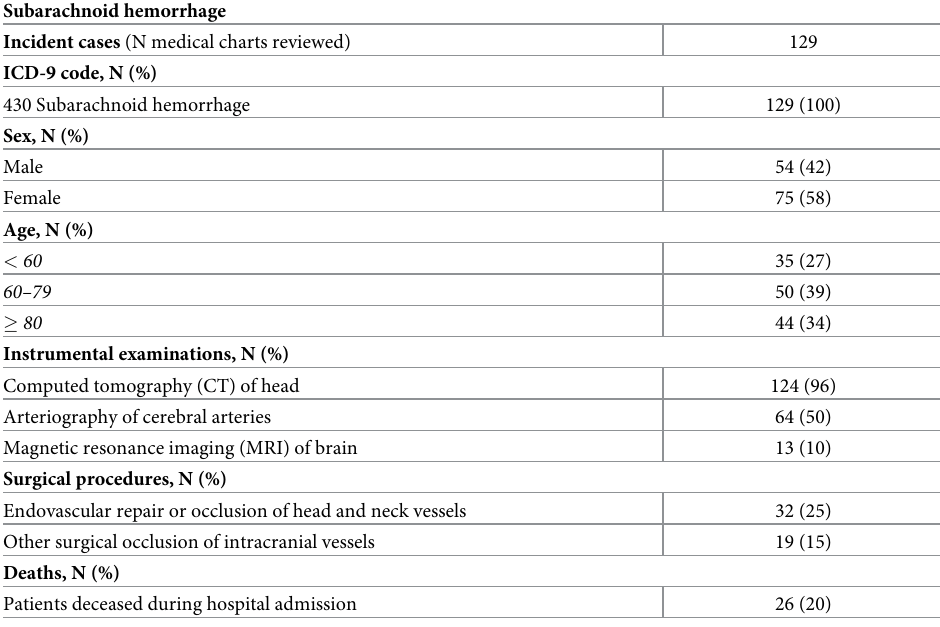
Table 2. Characteristics of patients with subarachnoid hemorrhage who were identified in the Regional Adminis- trative Database of Umbria. Subarachnoid